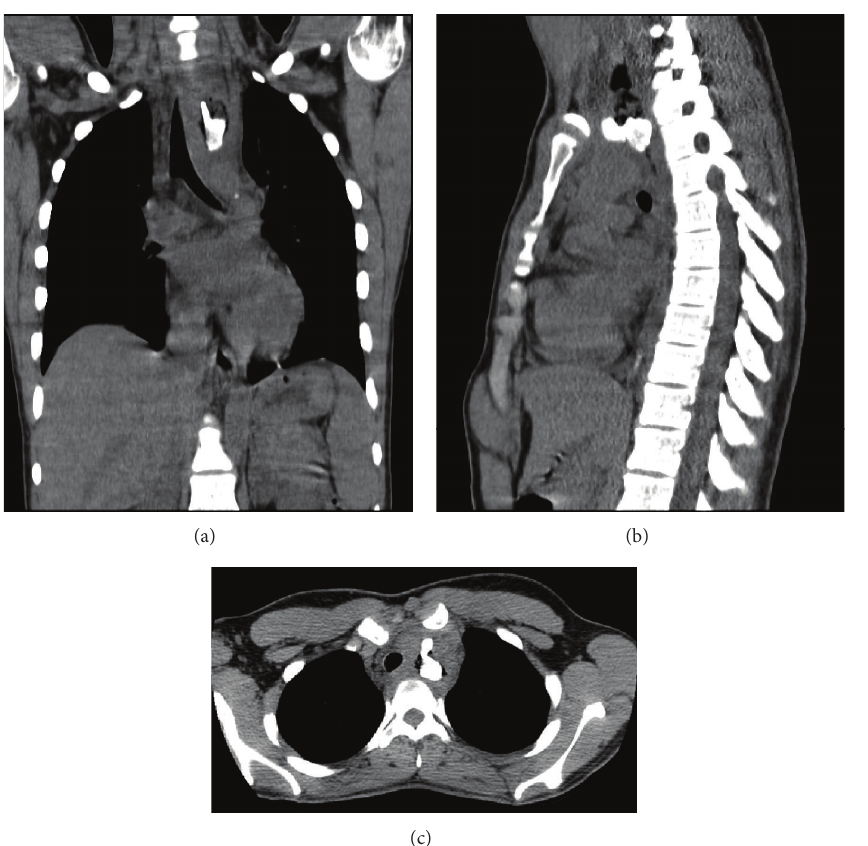
Figure 1: Computed tomography (CT) of the chest without contrast demonstrating a 3.2 cm (cranial/caudal) by 2.5 cm (anterior/posterior) Y-shaped foreign body within the anterior-superior mediastinum in the region of the esophagus. There is gas surrounding the mass. The foreign body has bone density and the gas is in part extraluminal. Edema is present in the circumference of the foreign body and is thought to shift the trachea from the left to the right, with compression of the airway. The soft tissue swelling is also evident surrounding the foreign body and esophagus, reflective of local inflammatory changes and hematoma secondary to the fistula connection between the esophagus and proximal innominate artery. (a) Coronal view. (b) Sagittal view. (c) Axial view.